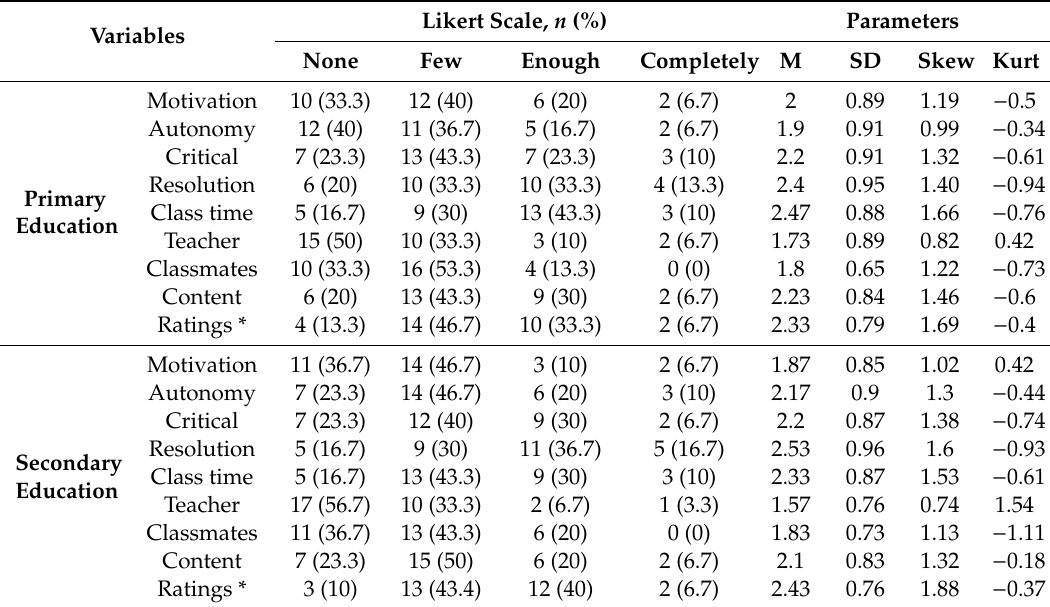
Table 4. Results obtained for study variables in control group.